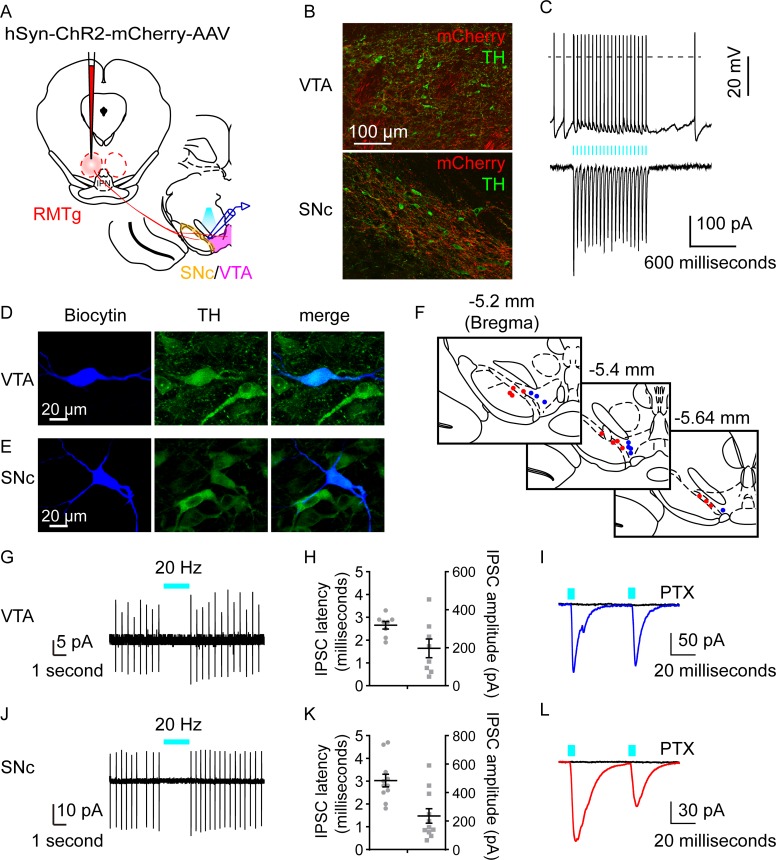
Optogenetic activation of terminals from rostromedial tegmental nucleus (RMTg) neurons inhibited the firing of midbrain dopaminergic neurons.(A) Schematic of the experiment. Adeno-associated virus–channelrhodopsin-2 (AAV-ChR2) was injected into the RMTg of Sprague–Dawley rats, and responses were recorded in the midbrain (ventral tegmental area [VTA]/substantia nigra compacta [SNc]). (B) Representative images of dense mCherry+ terminals (red) of RMTg neurons in VTA (top) and SNc (bottom). Tyrosine hydroxylase (TH, green) immunostaining was used to demarcate the VTA and SNc. (C) ChR2-mCherry expressing neurons showed fidelity of spiking (top) following 20 Hz blue light illumination in current-clamp mode. This depolarization coincided with inward current recorded under voltage clamp (bottom). (D, E) Fluorescence micrographs showing a recorded biocytin-filled neuron in the VTA (D) or the SNc (E) that expressed TH. (F) The location of connected biocytin-filled neurons across the rostrocaudal extent of the VTA (blue dots) or the SNc (red dots). (G, J) A typical cell-attached patch recording showed that brief blue light pulses totally suppressed spiking of DAergic neurons in the VTA (G) or SNc (J). (H, K) Latency (left axis) and amplitude (right axis) of light-evoked inhibitory postsynaptic currents (IPSCs) in the VTA (H) or SNc (K) TH-positive neurons (n = 8 cells for VTA or 11 cells for SNc from 6 rats). (I, L) Typical traces of postsynaptic currents from a VTA neuron (I) or a SNc neuron (L) evoked by blue light. The evoked currents were completely abolished by application of picrotoxin (PTX) (100 μM; black lines). Underlying data can be found in S1 Data.